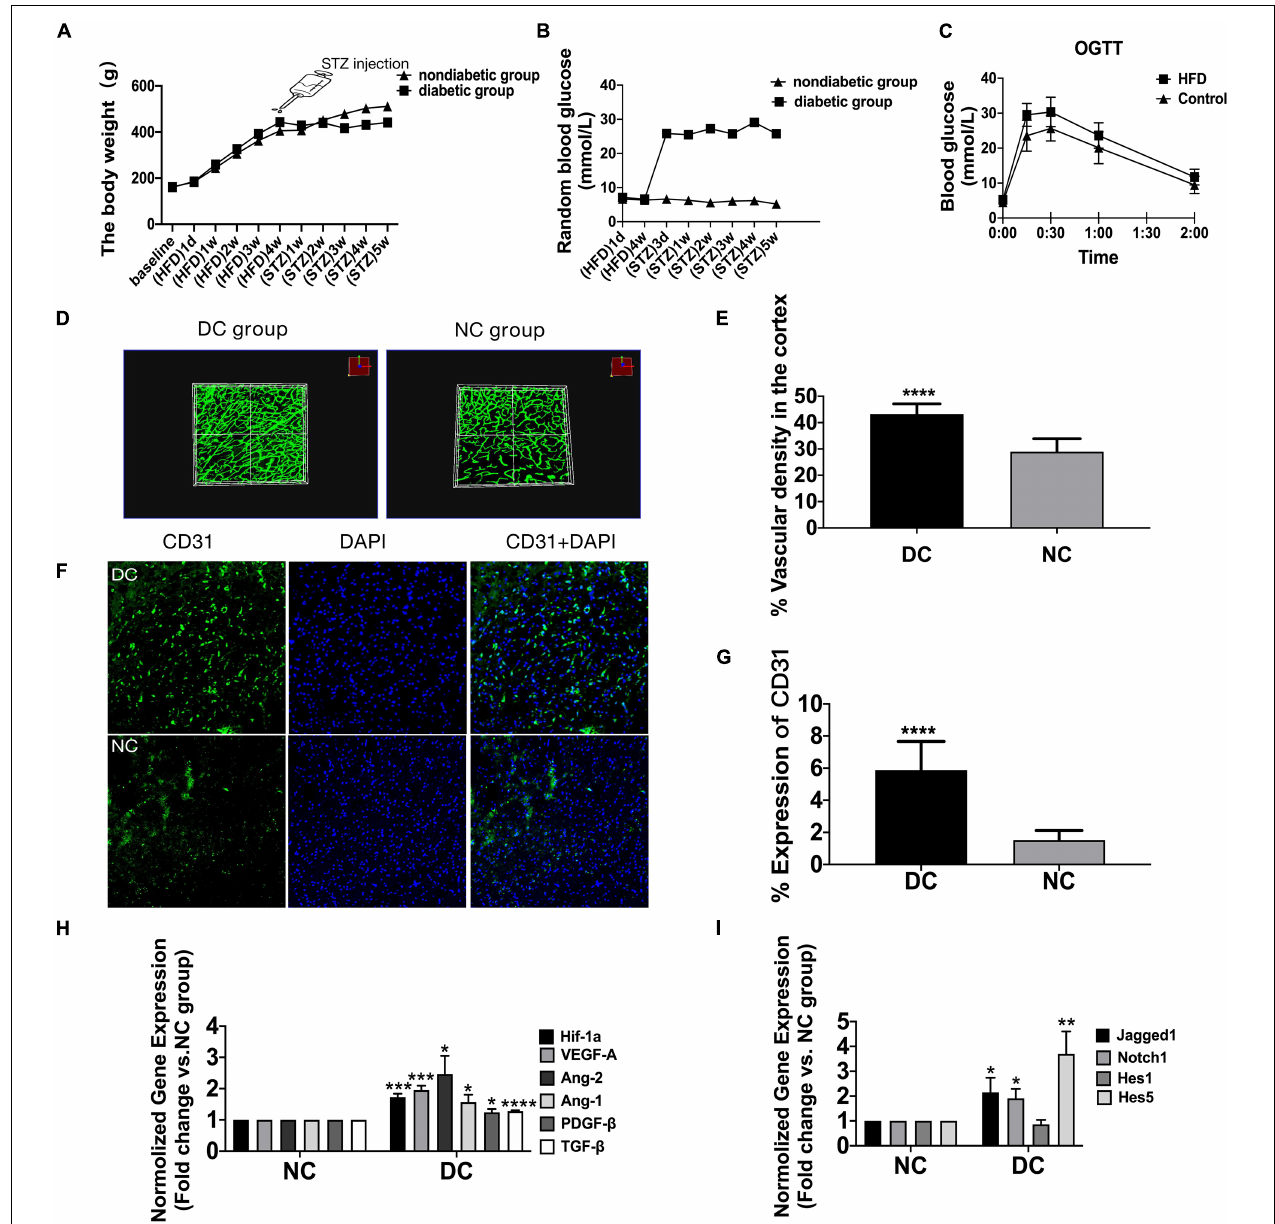
FIGURE 1 | The enhanced yet dysfunctional baseline neovascularization in HFD/STZ rat model before cerebral ischemia. (A) Mean body weight changes during the time of high-fat diet and after the STZ treatment ( n = 42 in each group). (B) Mean plasma glucose concentration changes during the time of high-fat diet and after the STZ treatment ( n = 42 in each group). (C) Mean plasma glucose concentration in response to an oral glucose challenge in chow-fed and HFD-fed rats ( n = 42 in each group). (D) Representative FITC-perfused cerebrovascular images from non-diabetic control and diabetic control rats showing differences in neovascularization in the cerebral cortex (Z-step was defined as 1.984 µ m, image size 512 × 512 pixels, 20 × lens). (E) Significant differences in vascular density were observed in the cortex in both non-diabetic control and diabetic control groups. (F) The staining of ECs in the cerebral cortex of diabetic control and non-diabetic control. Magnification × 200. Scale bar = 100 µ m. (G) ECs were markedly increased in the cortex of the diabetic control group compared with non-diabetic control group. (H) The gene expression of Hif-1a, VEGF-A, Ang-2, Ang-1, TGF- β , and PDGF- β was increased in diabetic control group compared with non-diabetic control